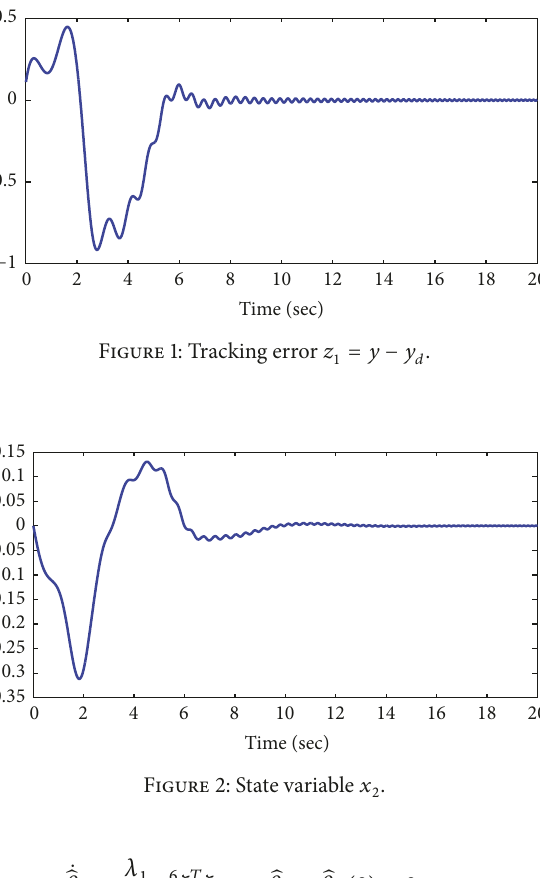
Figure 2: State variable 𝑥 2 .